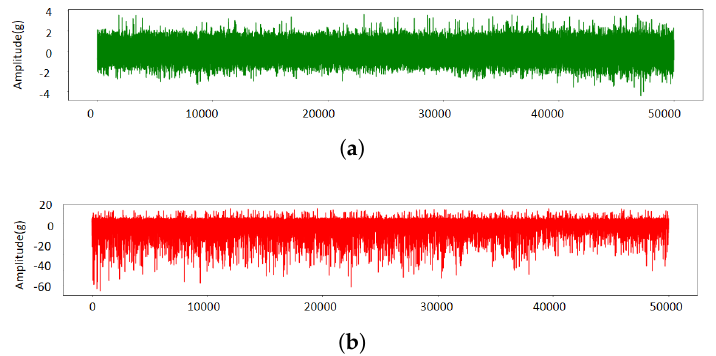
Figure 11. Gear pump vibration data ( a ) healthy condition ( b ) abrasion condition.